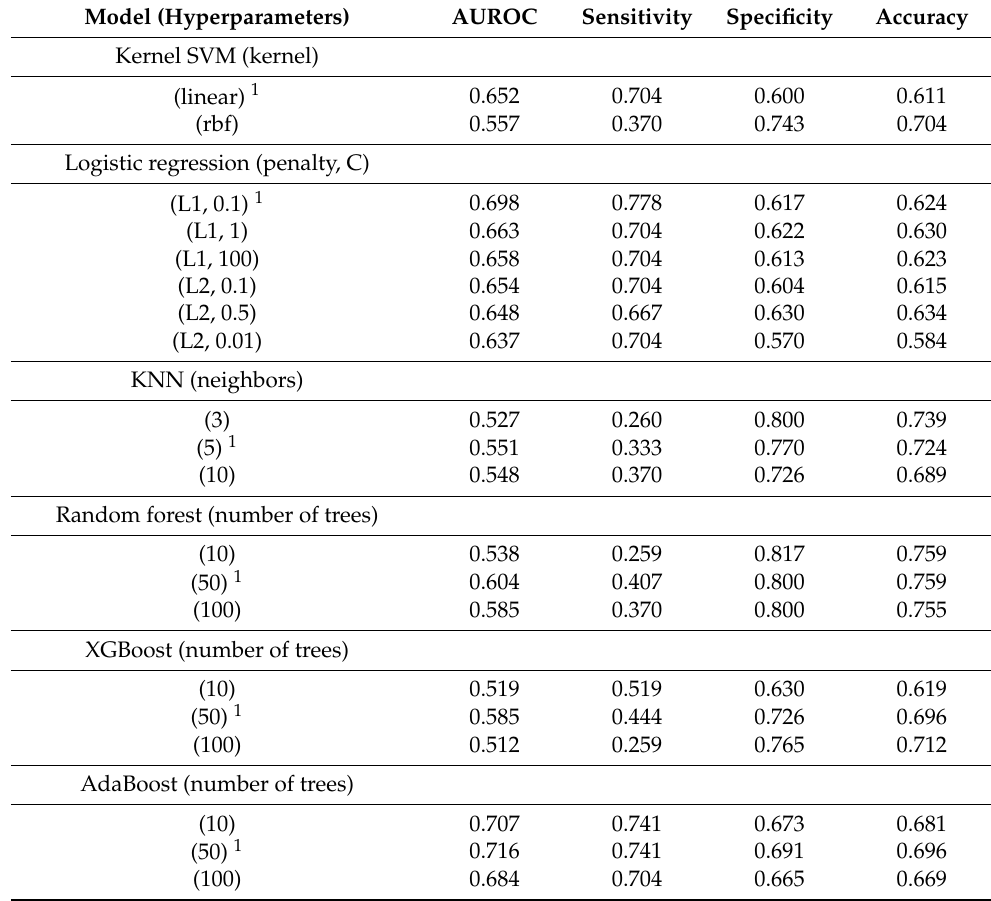
Table 2. Performance of the machine learning (ML) algorithms.